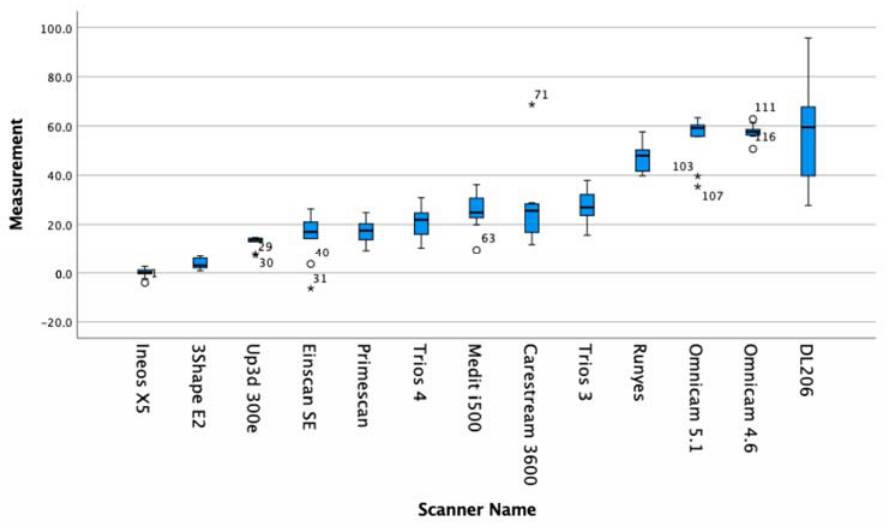
Table 4. Anova sig. between groups.